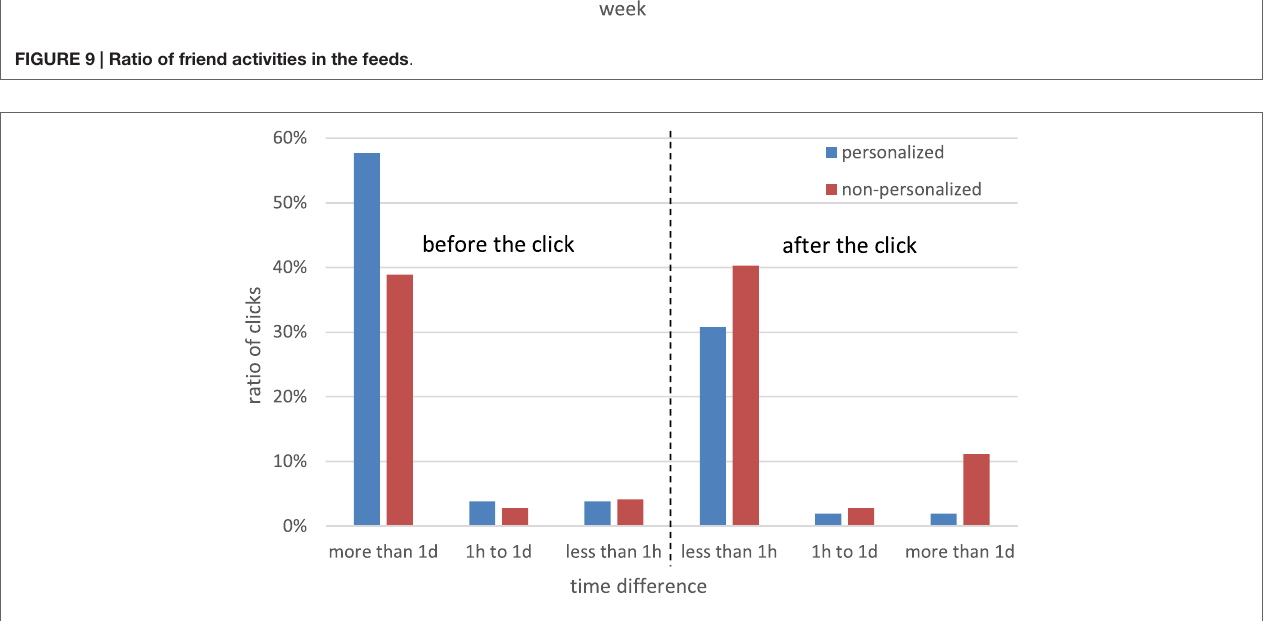
FigUre 10 | Time difference between feed clicks and establishment of friendship